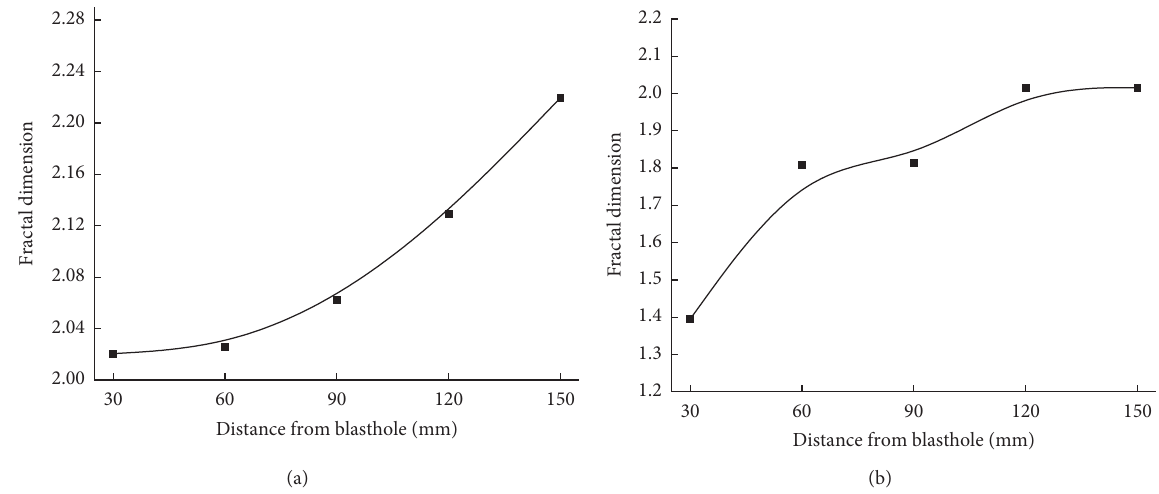
Figure 10: Fractal dimension curves at different distances. (a) Perpendicular to the slit direction. (b) Parallel to the slit